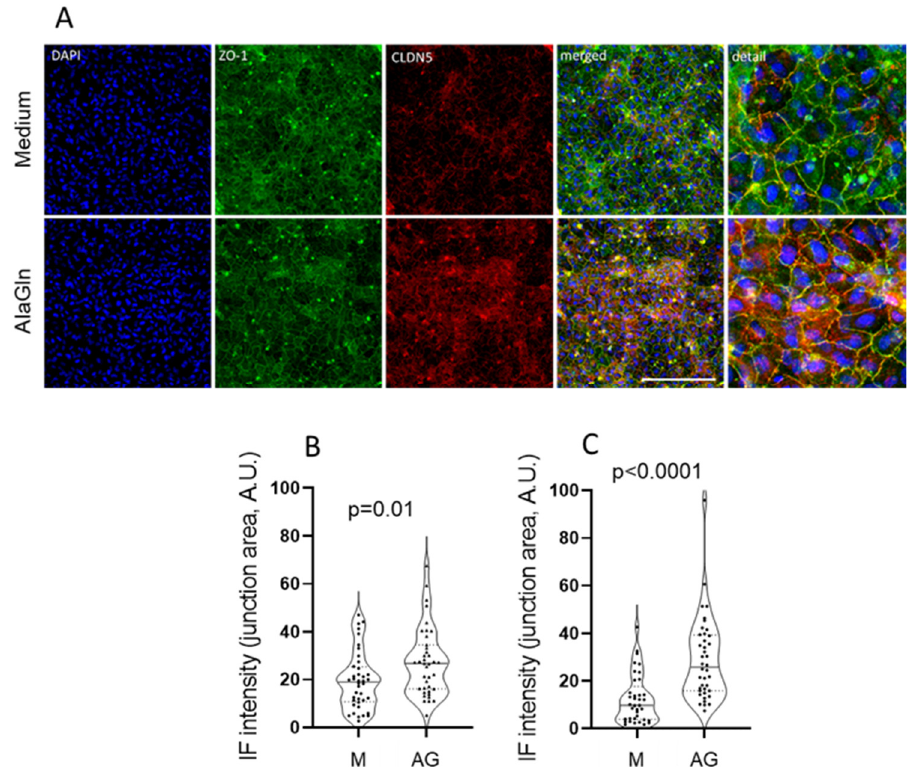
Figure 3. Visualization and quantification of tight junction protein. Immunocytochemical staining of Zonula Occludens-1 (ZO-1) and claudin-5 (CLDN5) in HUVEC monolayers on the same PC filters that were used for the TER and paracellular dextran permeability functional studies. In the upper row medium incubated HUVECs are shown and in the lower row HUVECs incubated with 24 mM AlaGln (AG) are shown ( A ). Immunofluorescence of ZO-1 and CLDN5 in the junction areas was quantified (z-stack spacing 3 µm). Scale bar = 100 µm. The quantification of AG treatment vs. medium control for ZO-1 is shown in ( B ) and for CDLN5 in ( C ).